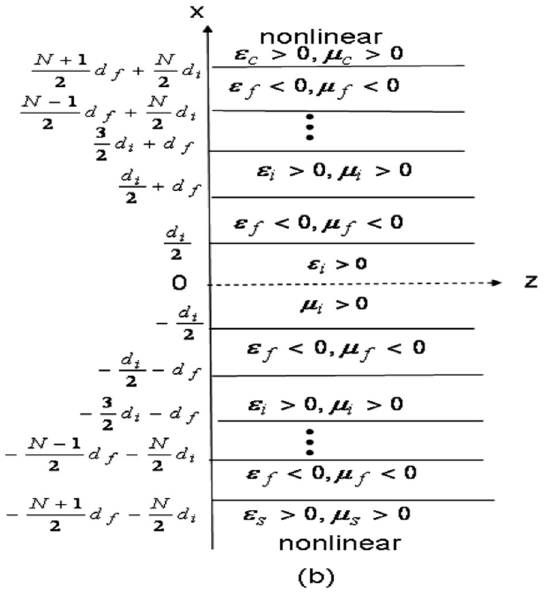
Figure 1. The structure of the multilayer metamaterials waveguide with nonlinear cladding and substrate: ( a ) for n = even, ( b ) for n = odd.